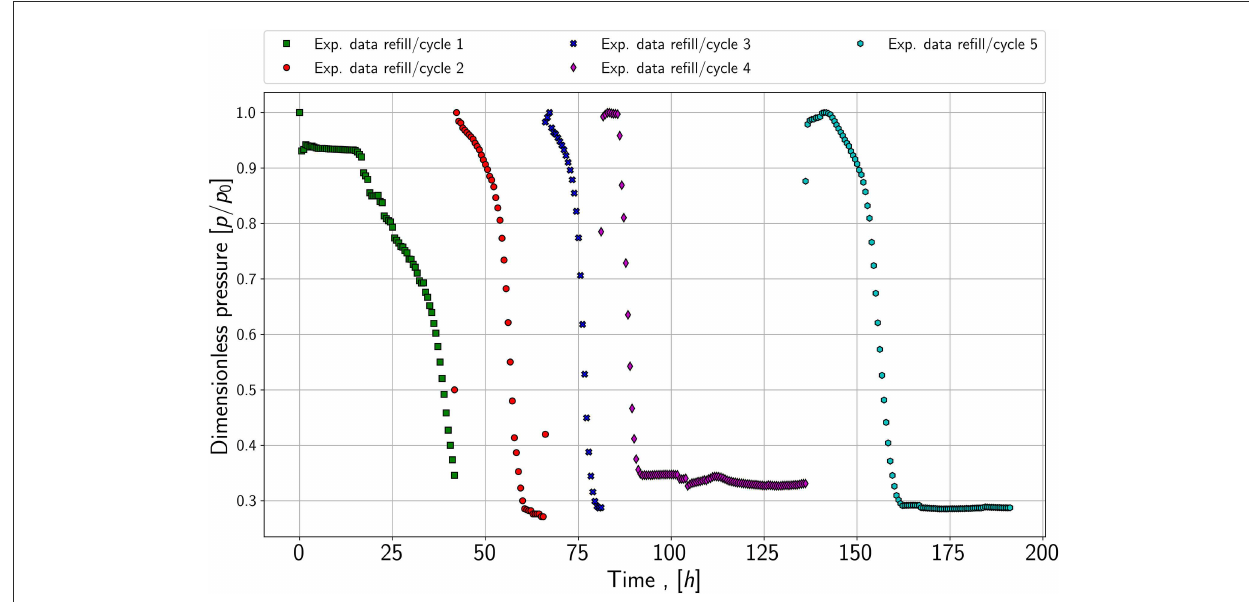
FIGURE4 Pressure versus time; refill experiment with five cycles; performed with species 1 and at a pressure of around 1,000